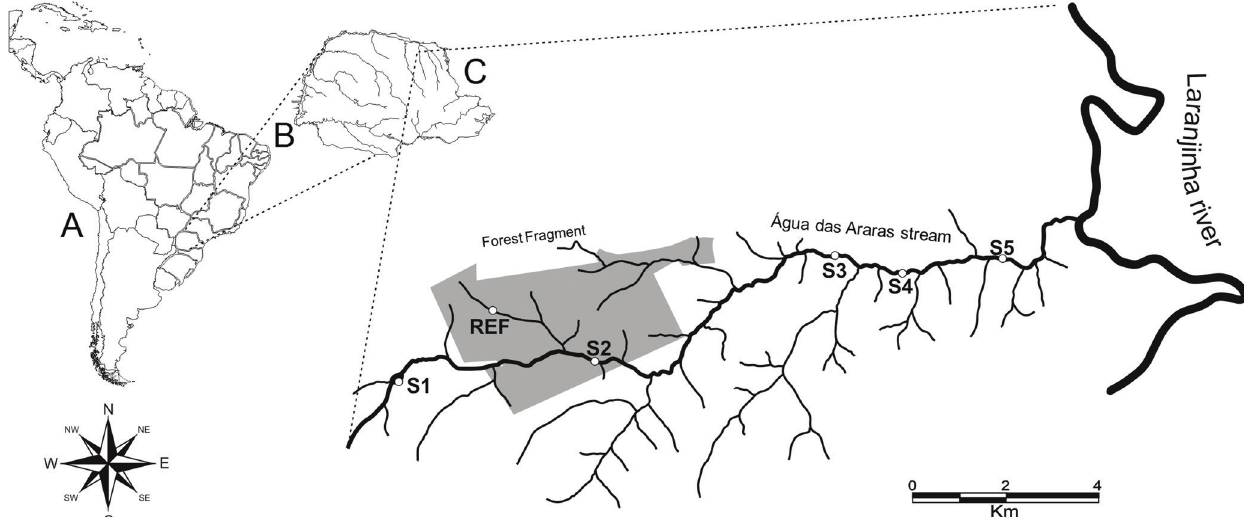
Fig. 1. Maps are showing South America (A), Paraná State (B) and Água das Araras stream (C) indicating the five experimental sites along of the stream (S1, S2, S3, S4, and S5) and the reference site (Ref), which is a small stream within a forest fragment named “Parque Estadual Mata São